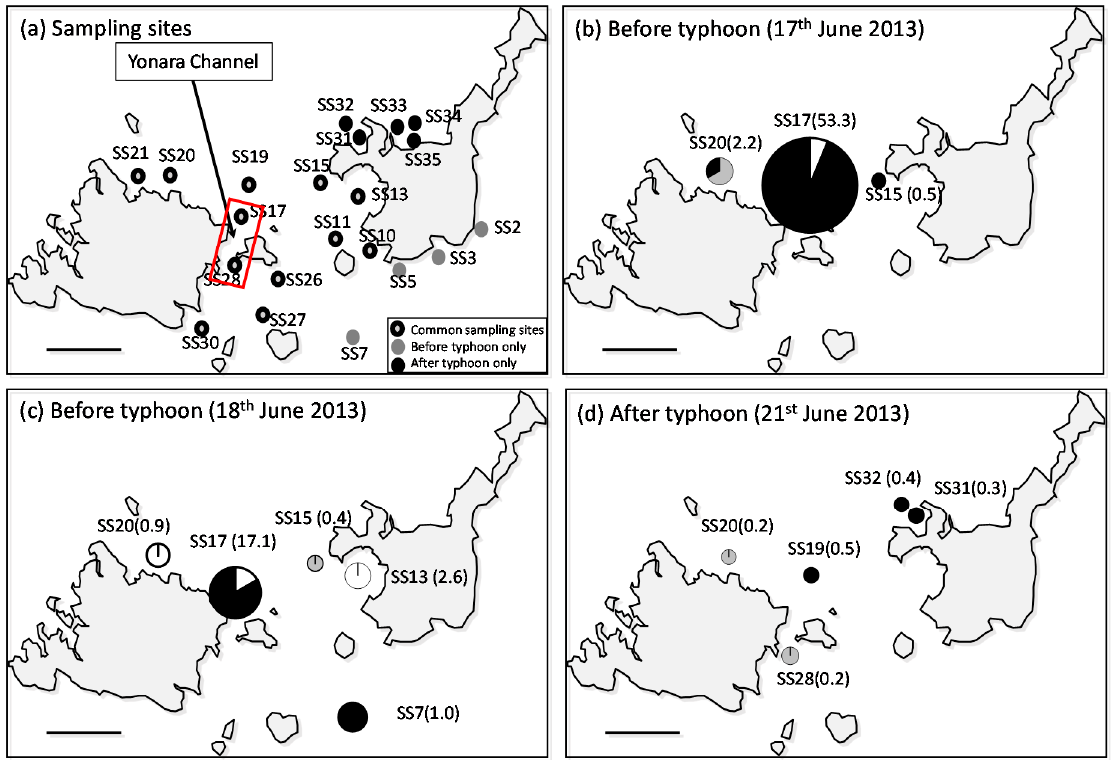
Figure 2. Distribution of Acanthaster planci larvae in the study area during the three field surveys. ( a ) Sampling sites; ( b ) distribution of identified A. planci larvae collected on 17 June 2013, ( c ) 18 June 2013, and ( d ) 21 June 2013 after a small typhoon. Numbers in parentheses indicate A. planci larval density (individuals/m 3 ). Colors in the pie chart represent larval developmental stages; black = brachiolaria, grey = bipinnaria, and white = gastrula.